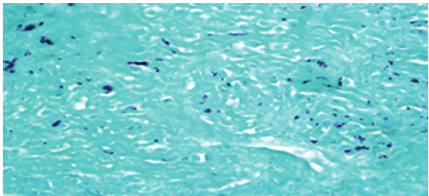
Figure 3: Acid fast stain of the liver biopsy which is positive for